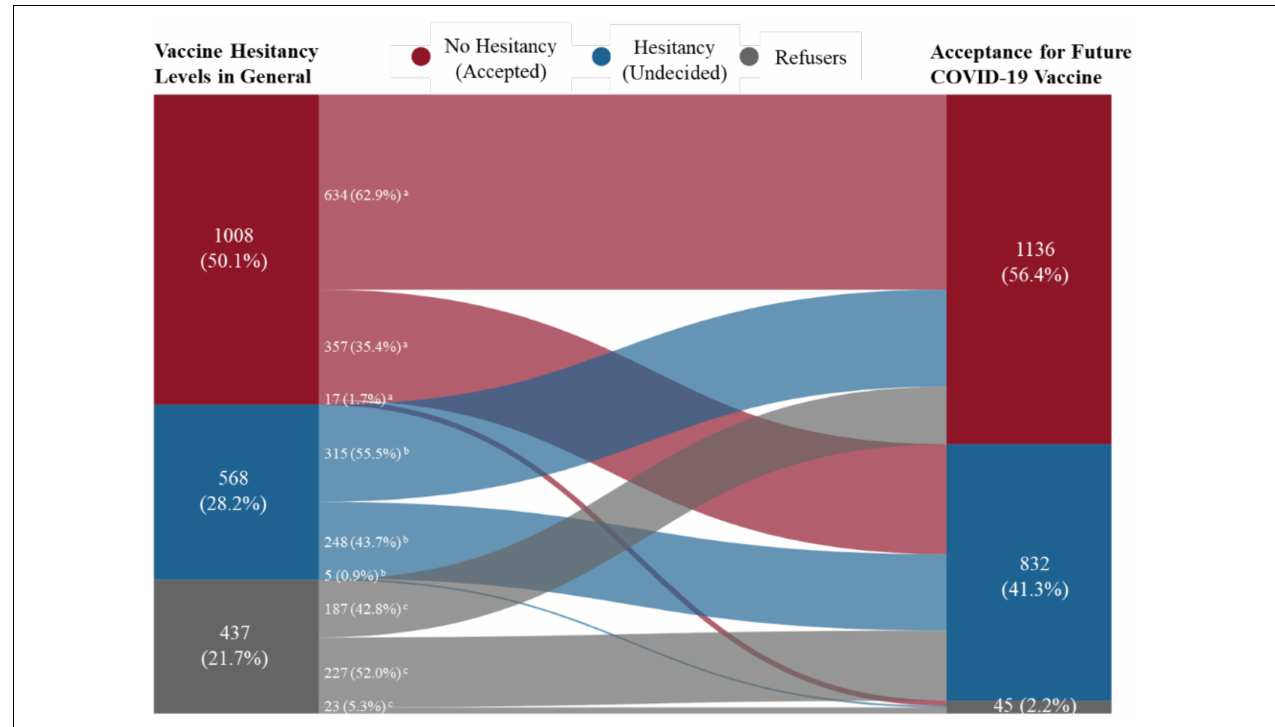
FIGURE 1 | Acceptance for future coronavirus disease 2019 (COVID-19) vaccine among participants with different general vaccine hesitancy levels by with Sankey diagram. a Number and proportion in “no hesitancy” general vaccine hesitancy group. b Number and proportion in “hesitancy” general vaccine hesitancy group. c Number and proportion in “refusal” general vaccine hesitancy